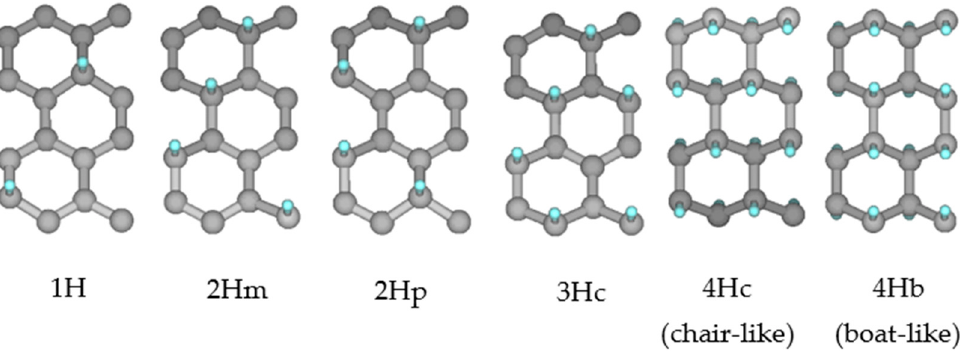
Figure 6. Different configurations of single-sided (1H, 2Hm, 2Hp, and 3Hc) and double-sided (4Hc and 4Hb) hydrogenated graphene. The cyan/grey spheres indicate H/C atoms, respectively. Table 1. Single-sided hydrogenation energies for different configurations.